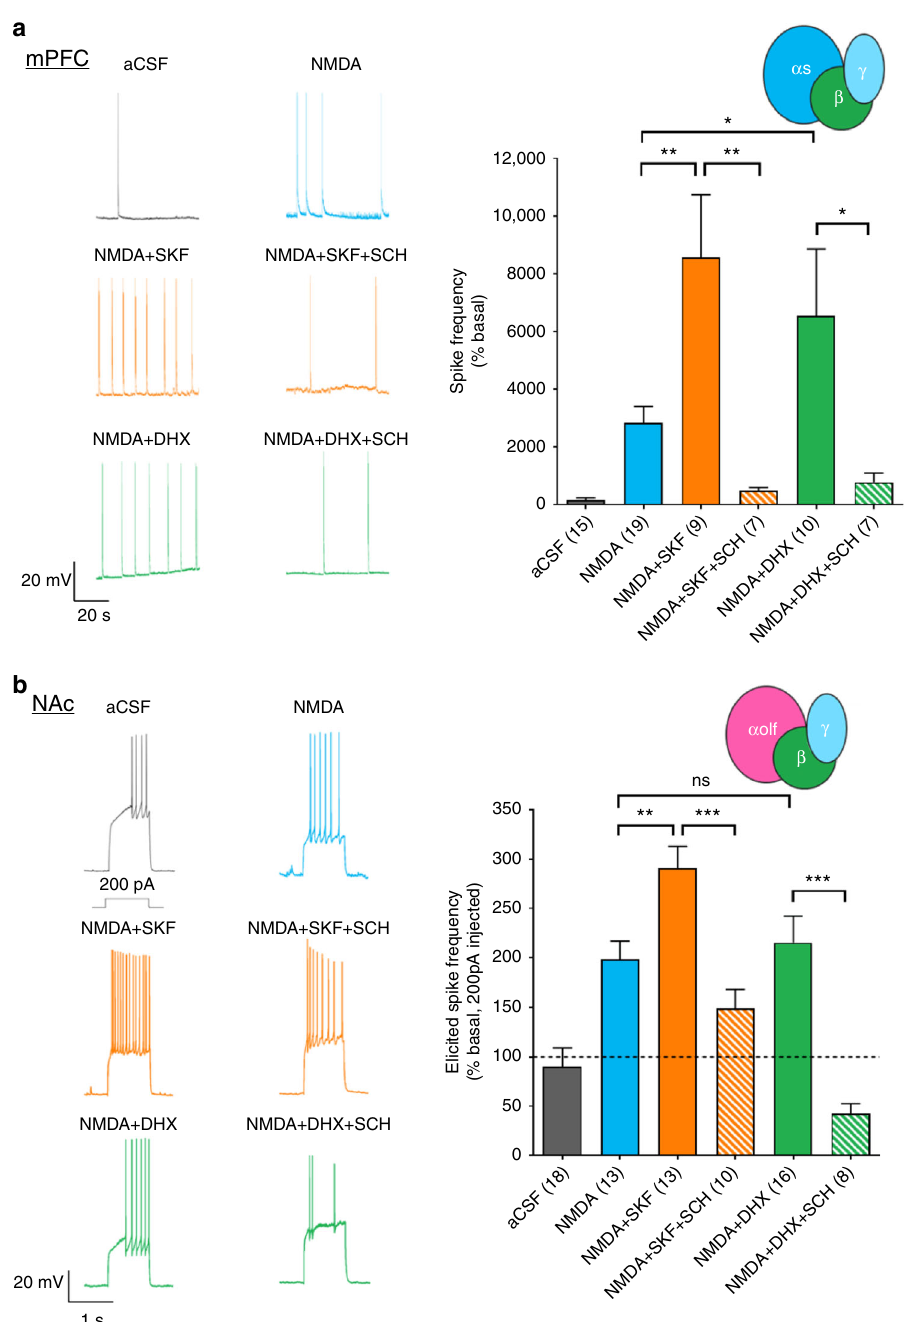
Fig. 4 Current clamp recording of drug-induced fi ring events for D1R-expressing pyramidal neurons in mPFC ( a ) and medium spiny neurons in NAc ( b ). Bar graph shows compiled data for spike frequency over 10 min drug treatment (all 10 µ M). For + SCH23390 condition, the antagonist is added in the aCSF and drug shown in the x-axis to ensure antagonist binding prior to the other drug ’ s effect. Example traces are shown on the left. Elicited spike frequency (200 pA injection via recording pipet) is shown for the NAc b . Number of cells recorded for each condition is shown in parenthesis. Values were statistically analyzed by one-way analysis of variance (ANOVA) repeated measure followed by Newman – Keuls post hoc test. p -values are as indicated: * p < 0.05, ** p < 0.01, or *** p < 0.001; NS for not signi fi cant. The error bars represent